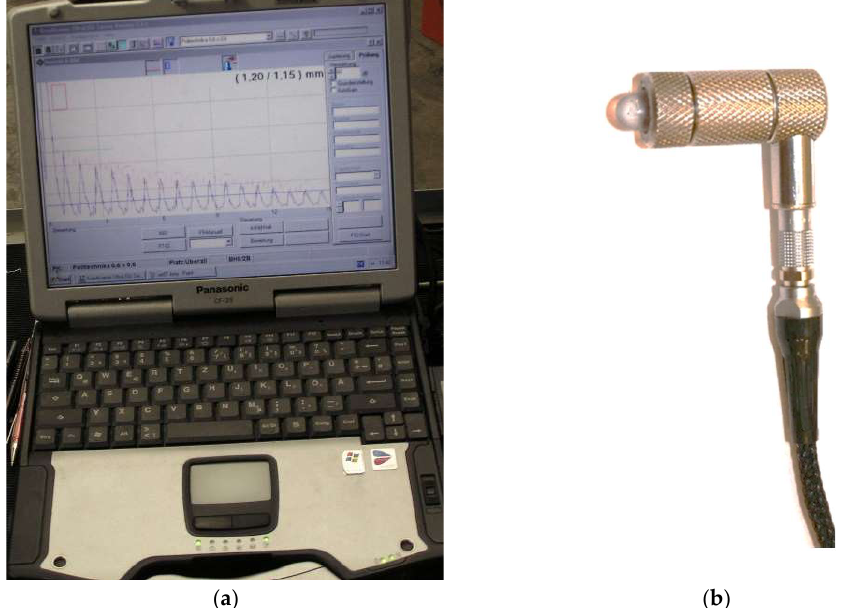
Figure 8. Ultrasonic equipment used in the research; ( a ) digital flaw detector, ( b ) ultrasonic head 20GX.